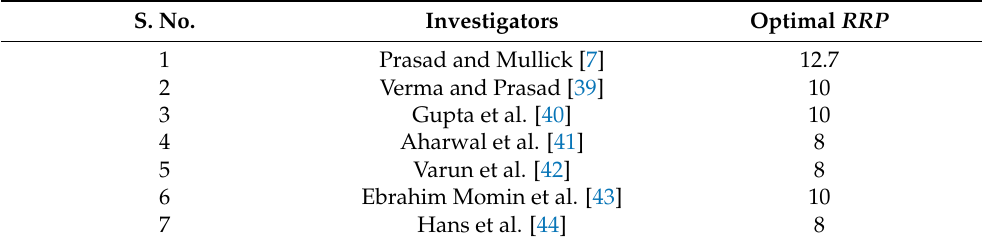
Table 5. Comparison between present numerical and previous experimental results for optimal RRP .